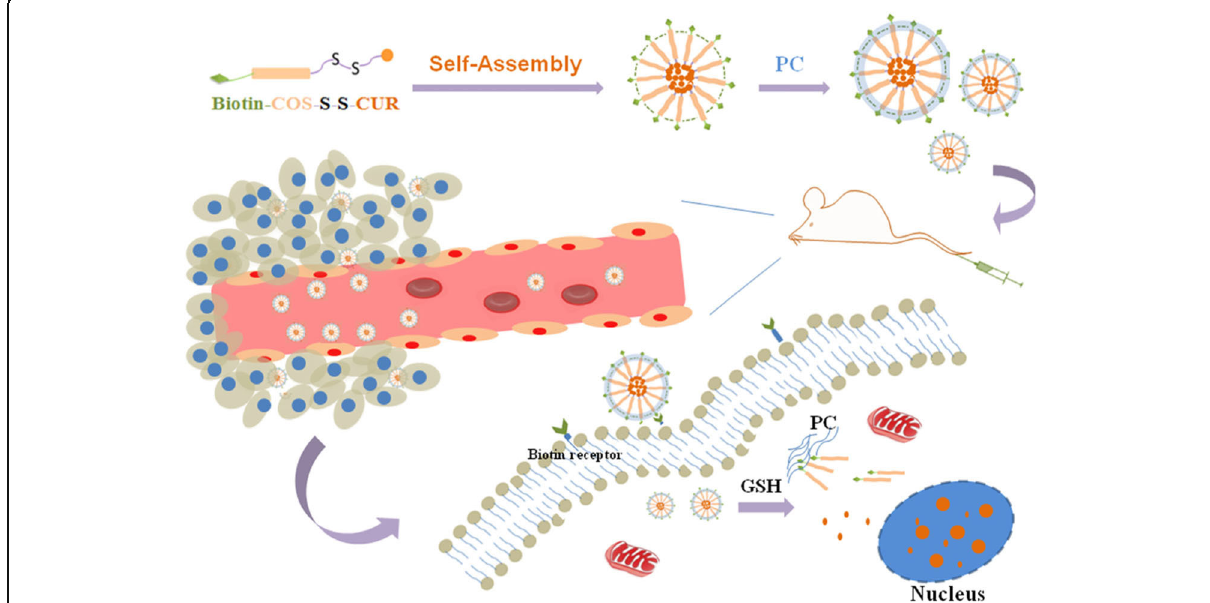
Fig. 1 Design and schematic illustration of